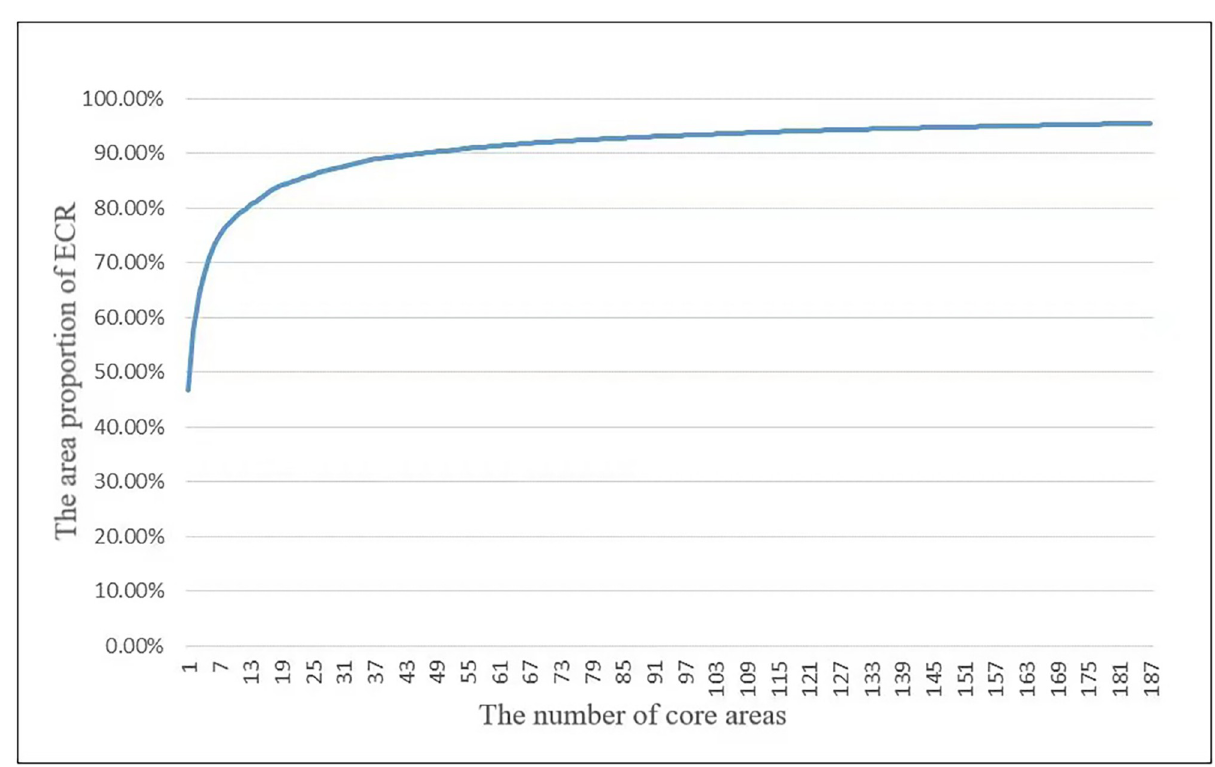
Fig 3. Area accumulation curve selected for the ecological conservation